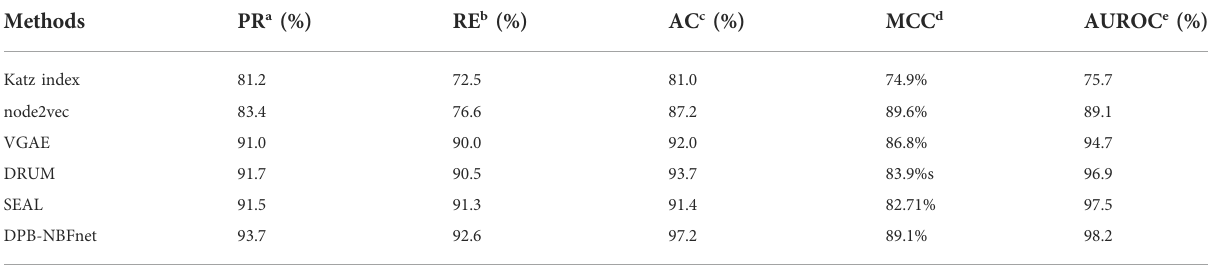
TABLE 1 Performance comparison of different methods on ENCODE datasets. Methods